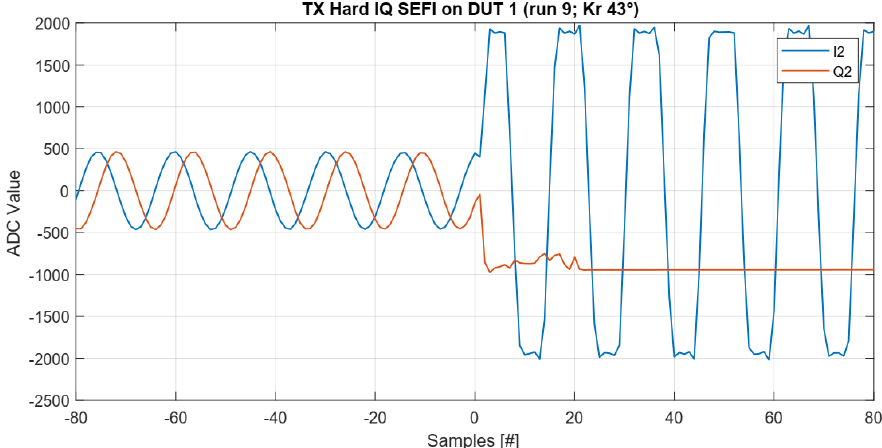
Figure 16. Hard IQ SEFI on channel 2 (I2 / Q2) of the DUT 1 transmitter, showing total loss of the IQ data.